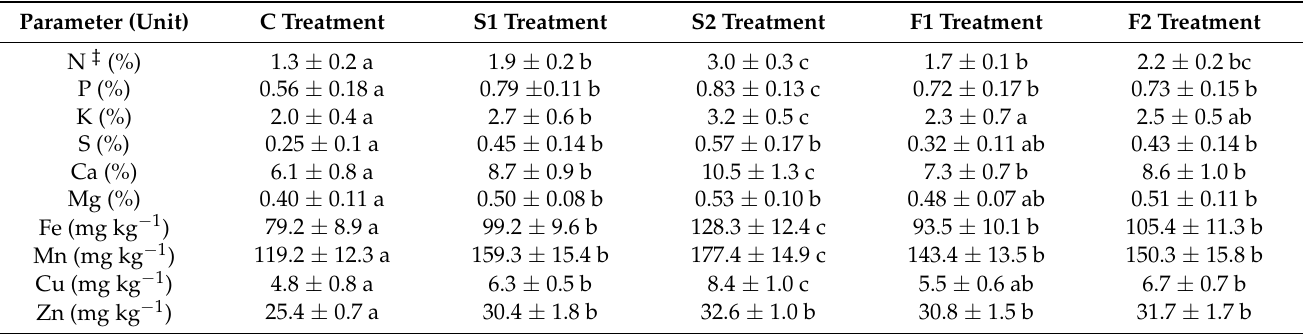
Table 3. Effect of biostimulant obtained from slaughterhouse sludge on tomato leaf mineral nutrient